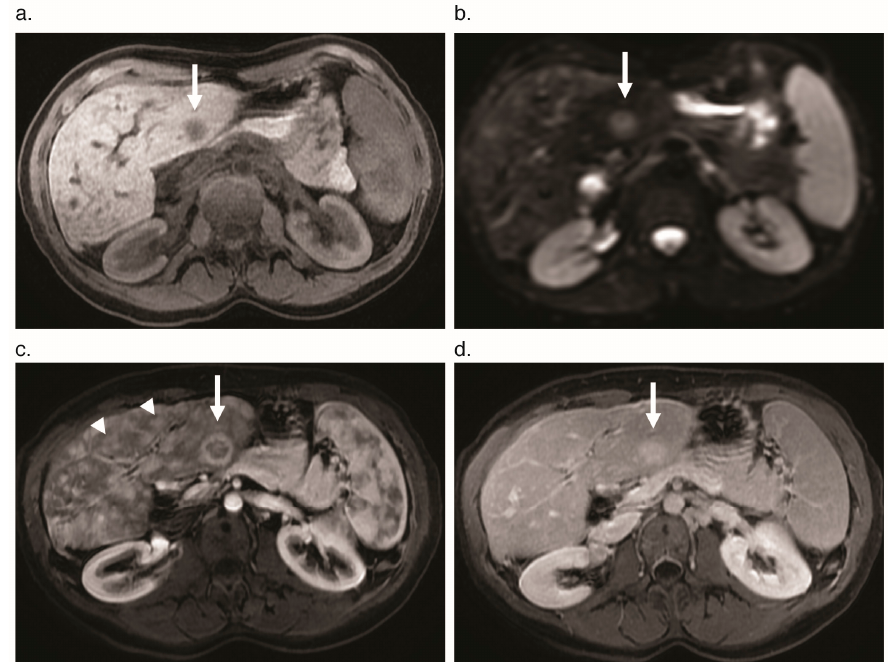
Figure 8. Focal nodular hyperplasia (FNH) mimicking cholangiocarcinoma in a 41-year-old woman with HHT. ( a ) Pre-contrast axial T 1 -weighted MR image shows a focal T 1 hypointense lesion in segment III of the left hepatic lobe (arrow). ( b ) The lesion shows restricted di ff usion at di ff usion-weighted MR imaging (arrow). ( c ) Axial T 1 weighted gadolinium-enhanced MR image with fat saturation shows corresponding peripheral enhancement (arrow) as well as numerous confluent vascular masses (arrowheads). ( d ) The segment III lesion is hyper-enhancing on delayed phase (arrow). The confluent vascular masses are notably isointense to liver parenchyma at this phase. Ultrasound-guided biopsy of the segment III lesion showed features of